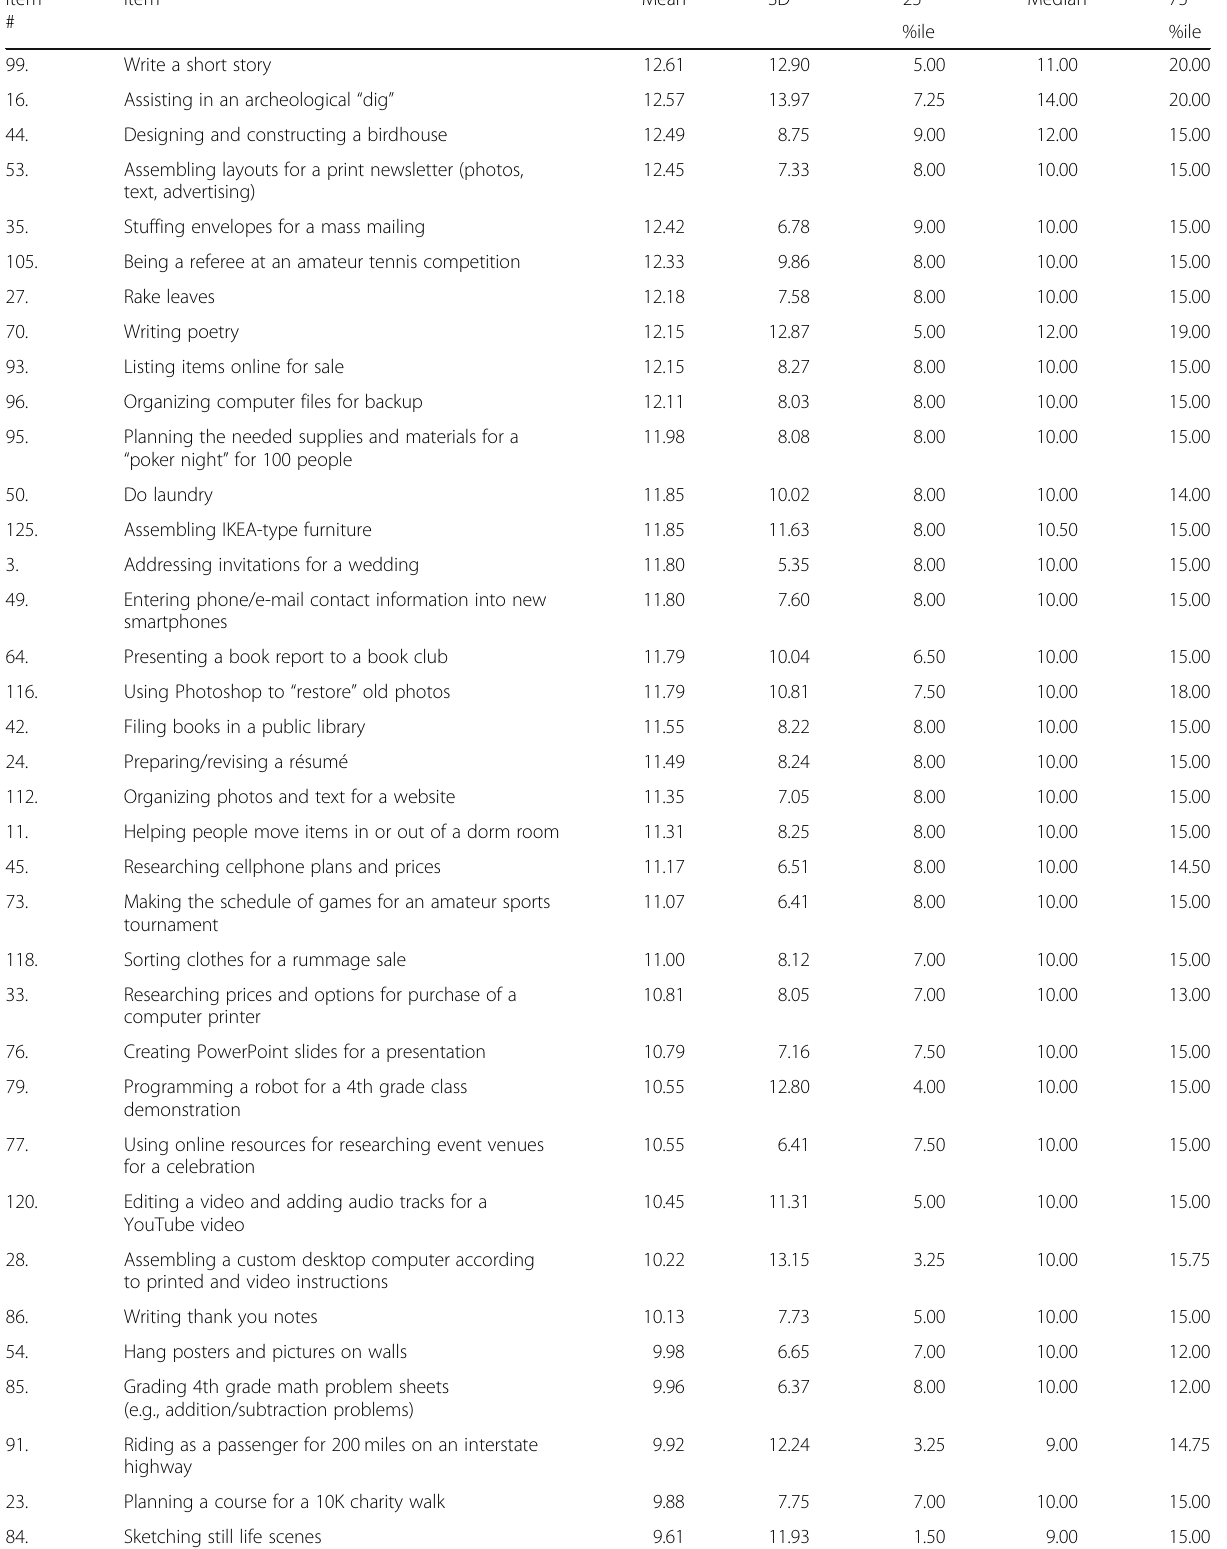
Table 1 Disutility judgments. Task items and descriptive statistics (mean, SD, 25%ile, median, 75%ile)